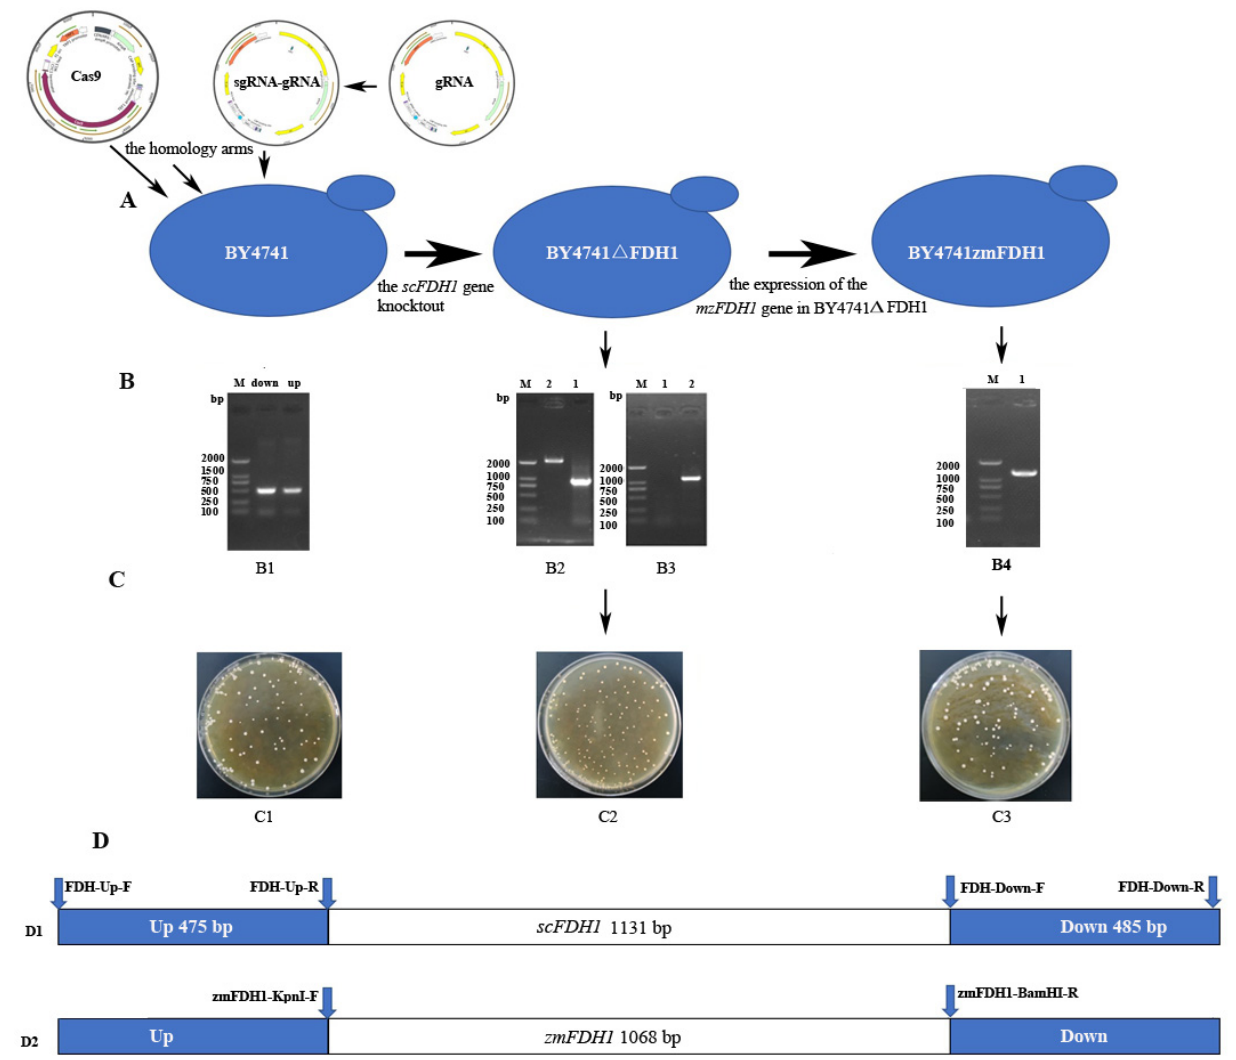
Figure 1. Strain construction. ( A ): Schematic of construction of BY4741 △ scFDH1 and BY4717mzFDH1 strains. ( B ): PCR amplification. (1) Product of the homology arms; M: maker; down: down repair homologous arm; up: up repair homologous arm. (2) Confirmation of BY4741 △ scFDH1 strain by PCR using primers FDH1-Up-F and FDH1-Down-R; M: marker; 1: negative colony; 2: positive colony. (3) Confirmation of BY4741 △ scFDH1 strain by PCR using primers FDH1-KpnI-F and H1-BamHI-R. (4) PCR result of BYmzFDH1 strain; M: marker; 1: negative colony; 2: positive colony. ( C ): Colonies of BY4741, BY4741 (cid:52) scFDH1 and BYmzFDH1 strains; M: marker; 1: negative colony. ( D ): The sites of the The FDH1 gene was amplified from Z. mellis and ligated into the plasmid pYES2, and